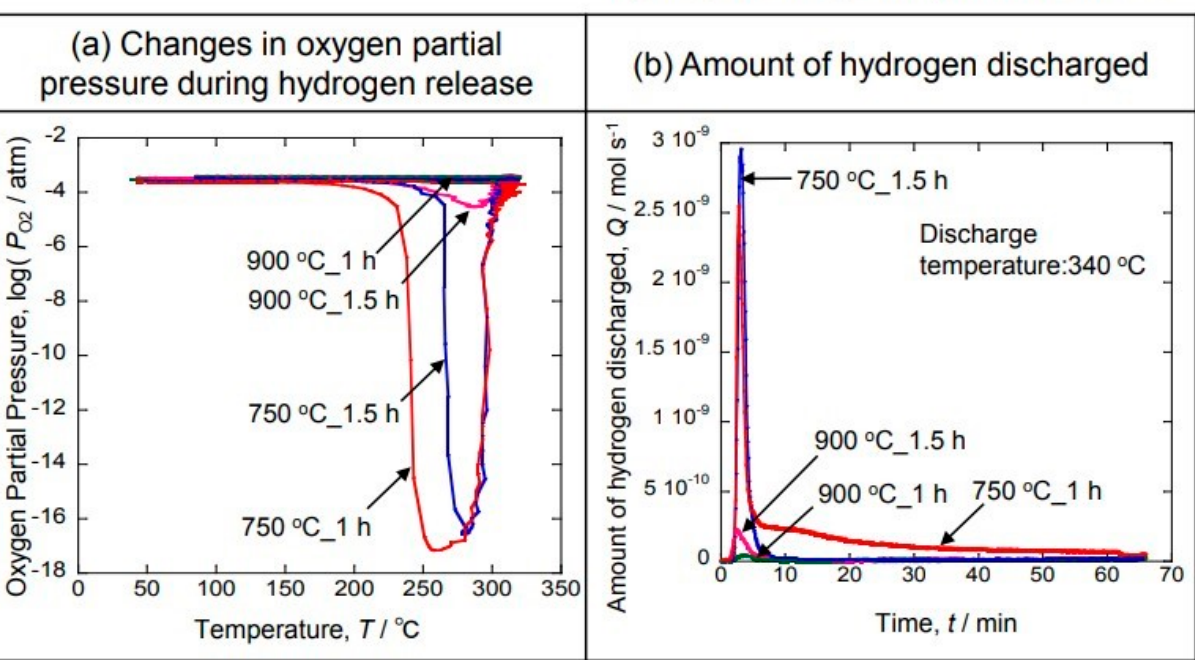
Figure 7. Oxygen partial pressure and amount of charged hydrogen of Ni after La deposition at ◦ C and 900 ◦ − 2.25 V in NaCl-KCl-5.0 mol%LaF 3 melts at 750 °C and 900 °C. − 2.25 V in NaCl-KCl-5.0 mol%LaF 3 melts at 750